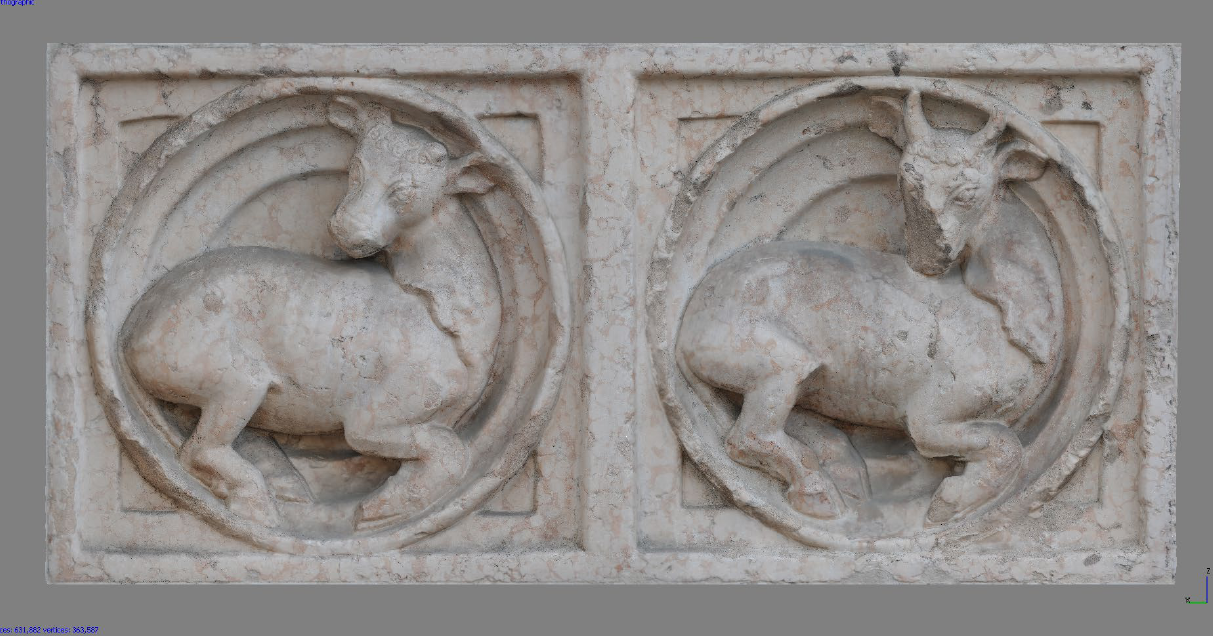
Figure 6. Photogrammetric model of a slab located on the zooforo of the Parma baptistery.